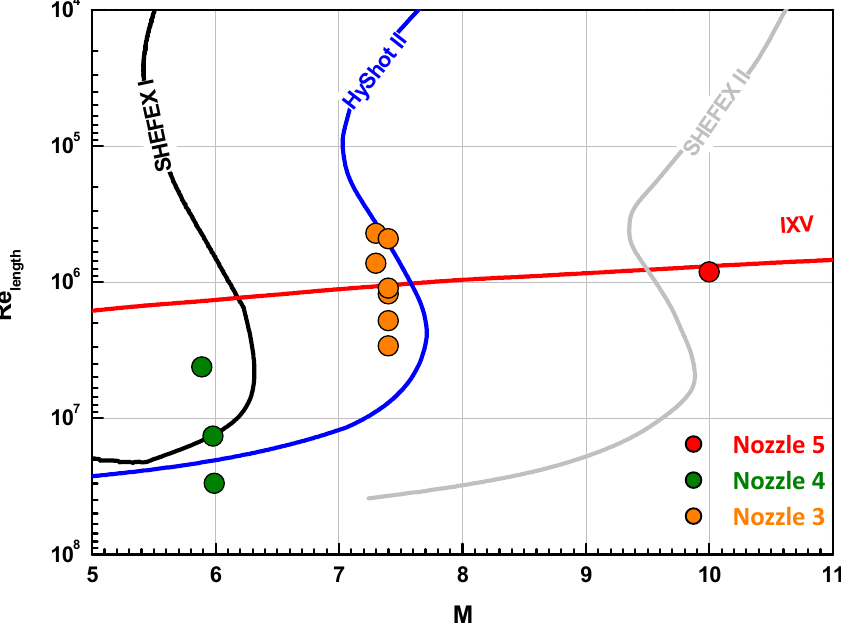
Figure 5: HEG operating conditions in terms of Mach and Reynolds